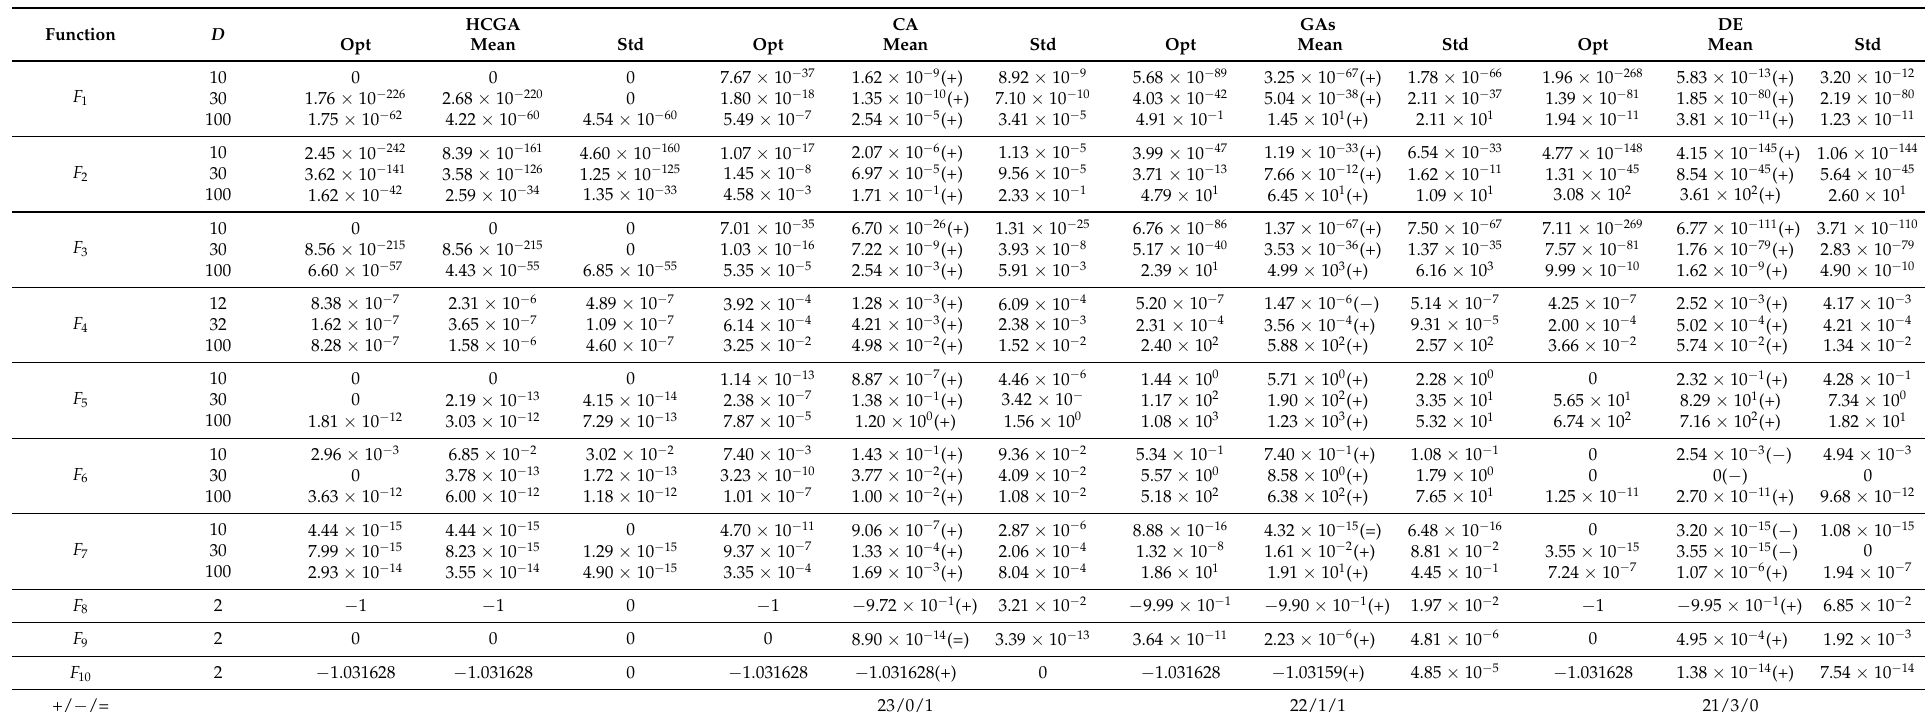
Table 7. Numerical experiment